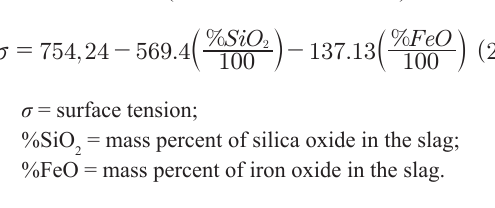
Figure 3: Relationship between the FeO content in slag and energy consumption 7 .